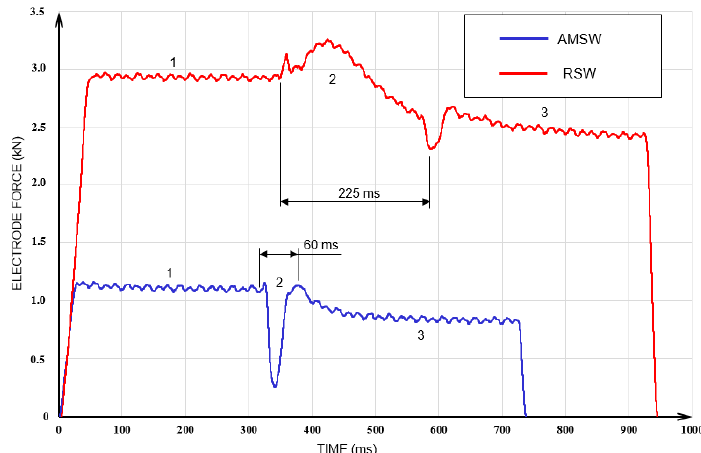
Figure 8. Comparison of the force behavior between the spot welding process using additive manufacturing (AMSW) and the resistance spot welding (RSW) process on zinc coated sheets.